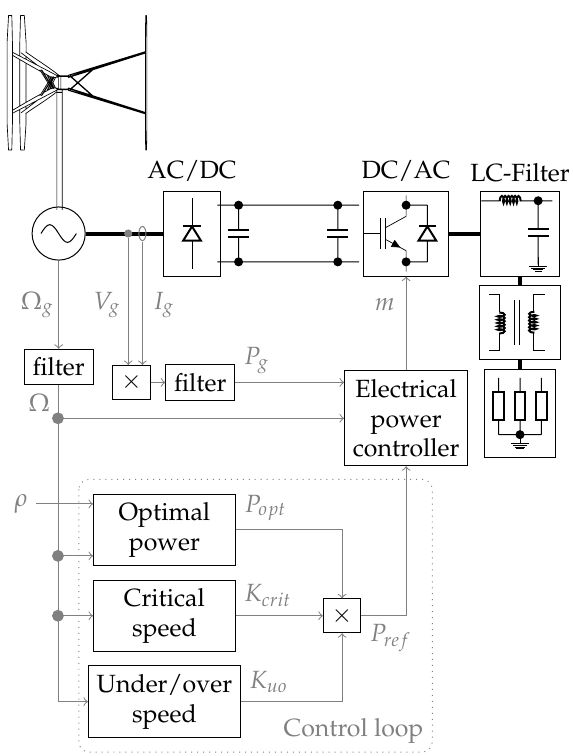
Figure 1. Overview of the control